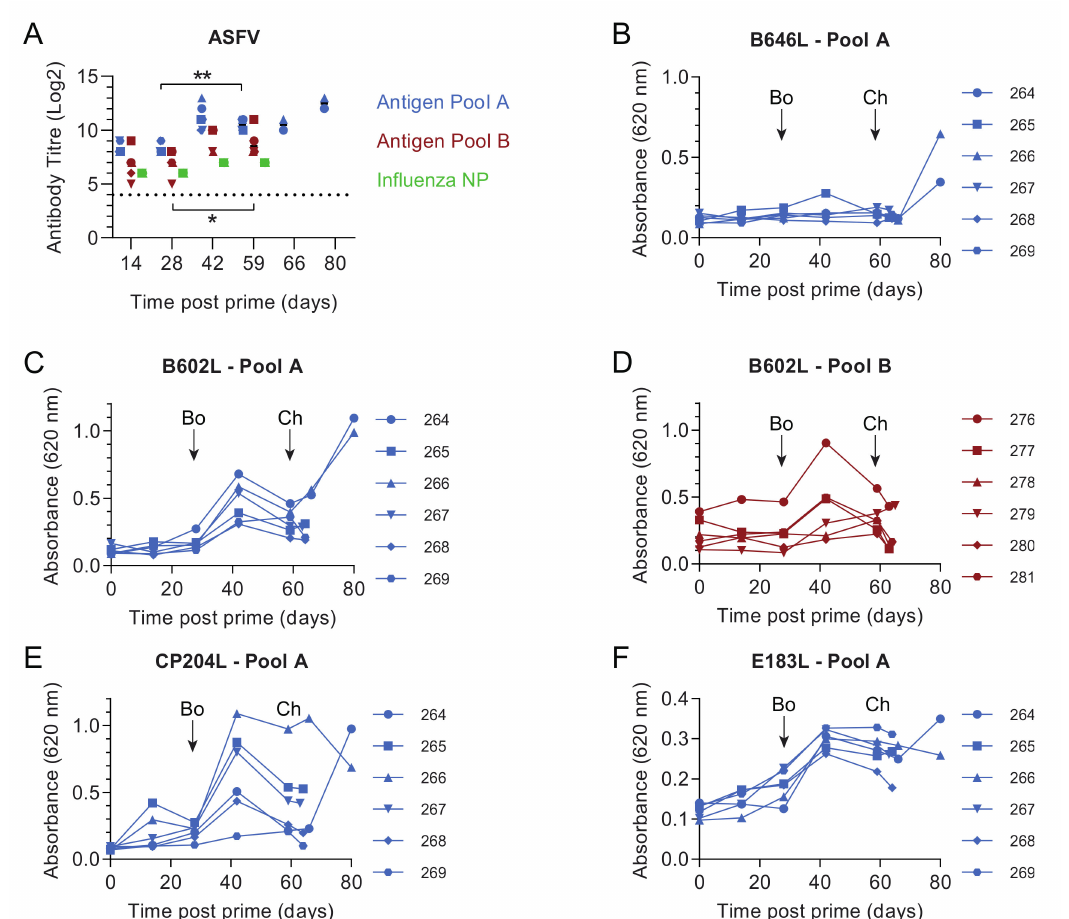
Figure 1. Antibody responses in pigs from experiment 1 primed with rAd encoding Antigen Pool A (blue), Antigen Pool B (red) or influenza NP (green). Animals were boosted with rAd / MVA 28 days after priming and challenged with ASFV 59 days after priming. ( A ) The titer of anti-ASFV antibodies in the serum of the indicated animals was determined by immunoperoxidase assay. Antibodies to ASFV proteins B646L ( B ), B602L ( C , D ), CP204L ( E ) and E183L ( F ) were detected in 1:100 dilutions of serum collected from the indicated animals at the indicated times post-prime by ELISA, and expressed as the absorbable at 620 nm. Timing of boost (Bo) and challenge (Ch) are indicated on panels B to F. Di ff erences between antibody titres were assessed by repeated-measures two-way ANOVA,* p ≤ 0.05, ** p ≤